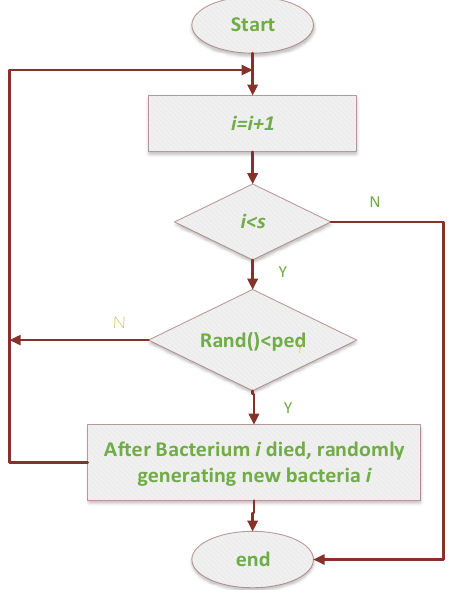
Figure 1. Migration operation flow chart.